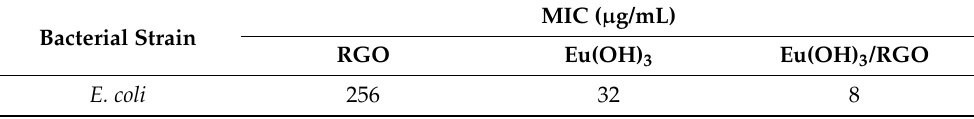
Table 2. Minimum inhibitory concentrations (MIC) of RGO, Eu(OH) 3 , and Eu(OH) 3 /RGO.